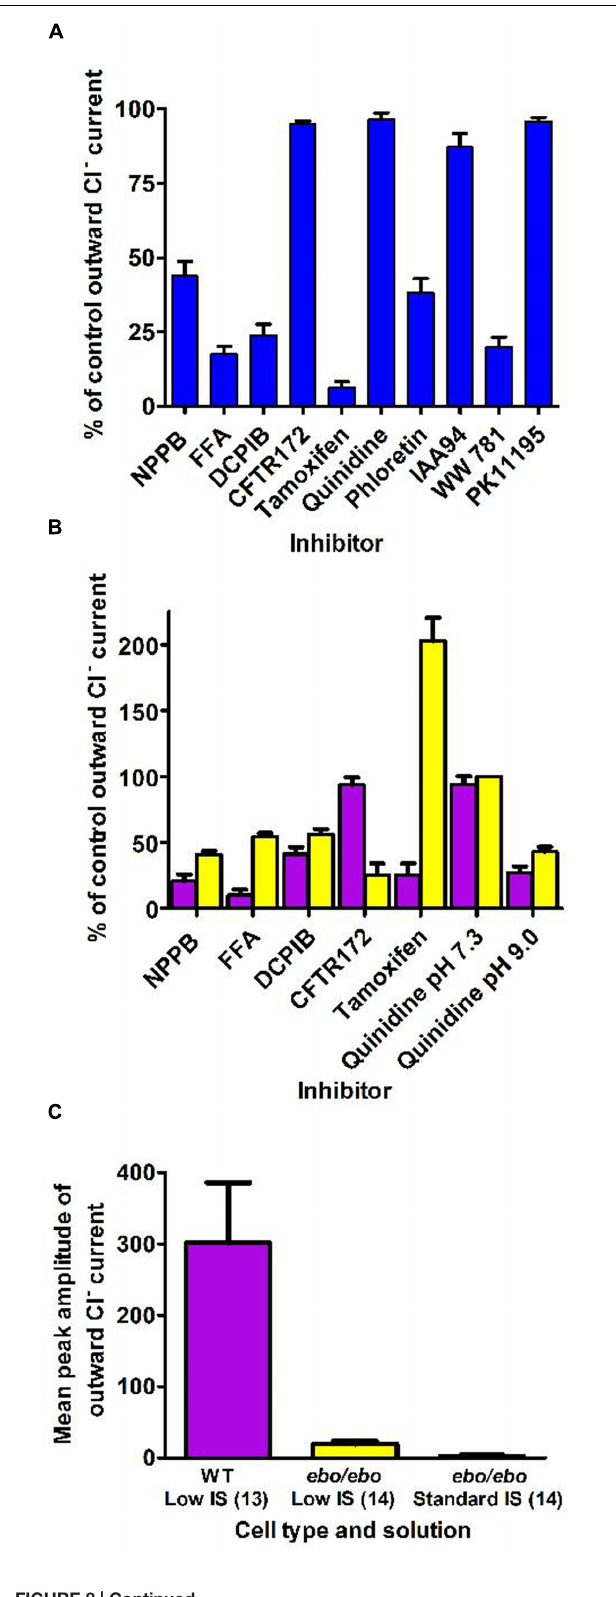
FIGURE 8 | (A) Pharmacology of the dialysis activated current in HVCN1 – / – C57BL/6 mice neutrophils. Concentrations of inhibitors used (numbers of cells tested) were: NPPB 100 µ M (14), FFA 200 µ M (13), DCPIB 10 µ M (4), CFTR- 172 10 µ M (4), tamoxifen 10 µ M (4), quinidine 100 µ M pH 7.3 (5), phloretin 200 µ M(2),IAA9450 µ M(6),WW78125 µ M(5),PK1119520 µ M(4).Theerror bars represent standard error of the mean. (B) Pharmacology of the Cl – current in WT BALB/c mice (purple bars) and of the residual Cl – current in the ebo/ebo BALB/c mice (yellow bars). Concentrations of inhibitors used (number of WT cells, number of ebo/ebo cells used): NPPB 100 µ M (9,9), FFA 200 µ M (5,5), DCPIB 20 µ M (8,9), CFTR-172 10 µ M (4,2), quinidine 100 µ M pH 7.3 (4,2), quinidine 100 µ M pH 9.0 (4,2), tamoxifen 10 µ M (4,6). The error bars represent standard error of the mean. (C) Ionic strength sensitivity: while a significant reduction of the outward Cl – current recorded in low ionic strength intracellular solution is observed in ebo/ebo neutrophils compared to WT neutrophils, the residual Cl – current in ebo/ebo neutrophils remains largely sensitive to ionic strength when in standard ionic strength